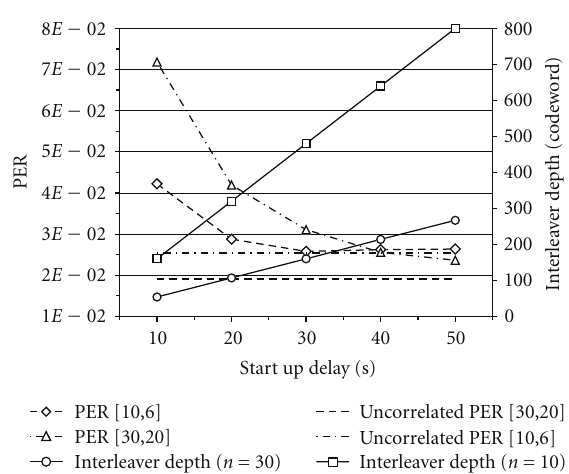
Figure 5: Residual PER and interleaver depth versus start-up